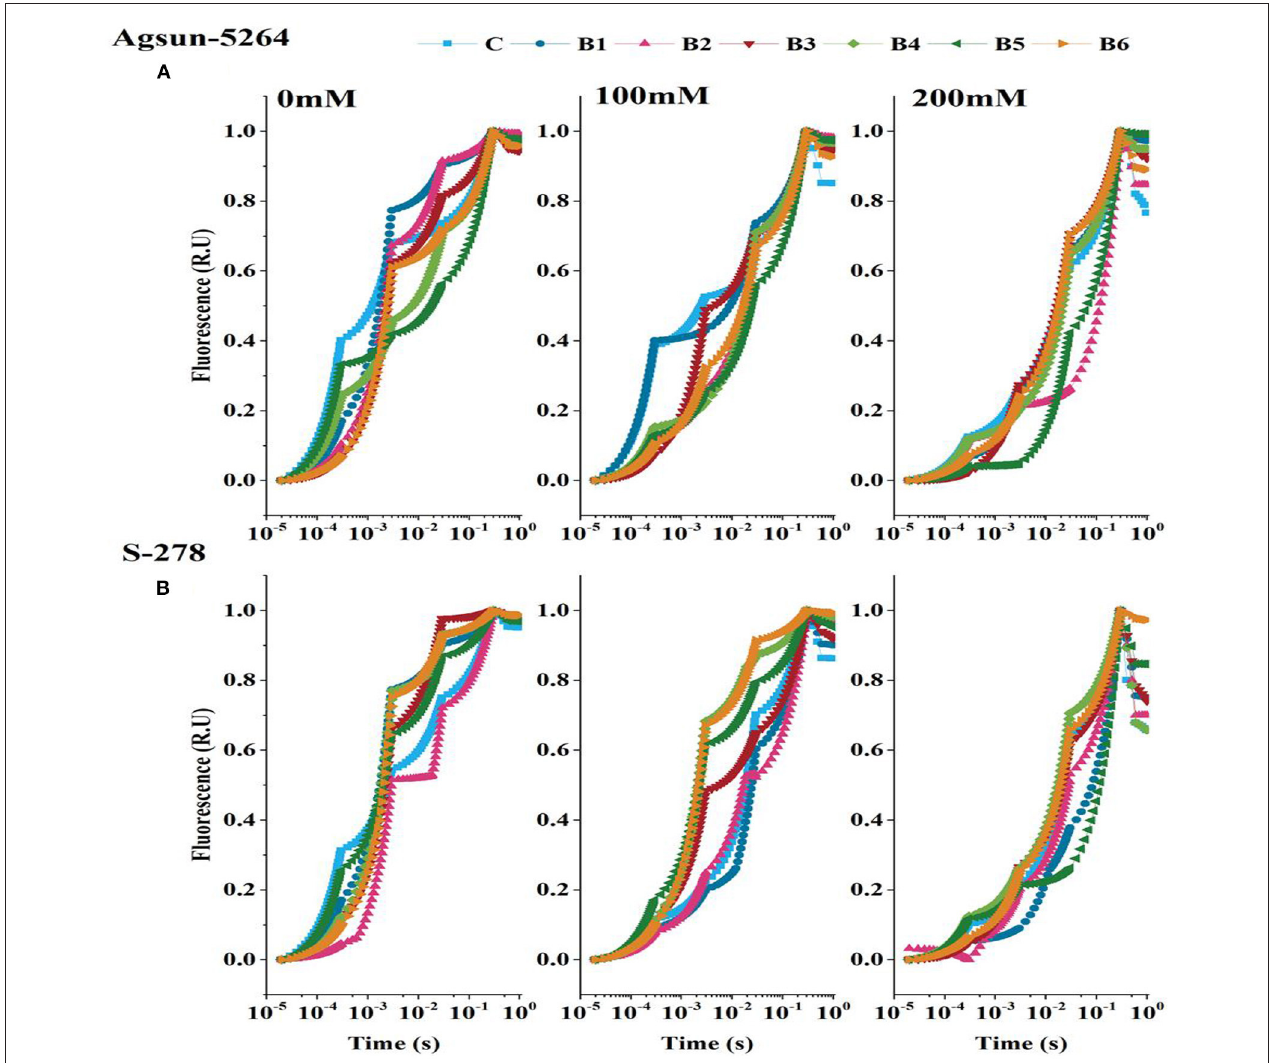
FIGURE 5 | Effect of halophilic microbial strains on Chlorophyll a fluorescence induction curve (OJIP) of sunflower cultivars. (A) Agsun-5264 and (B) S-278 under salinity